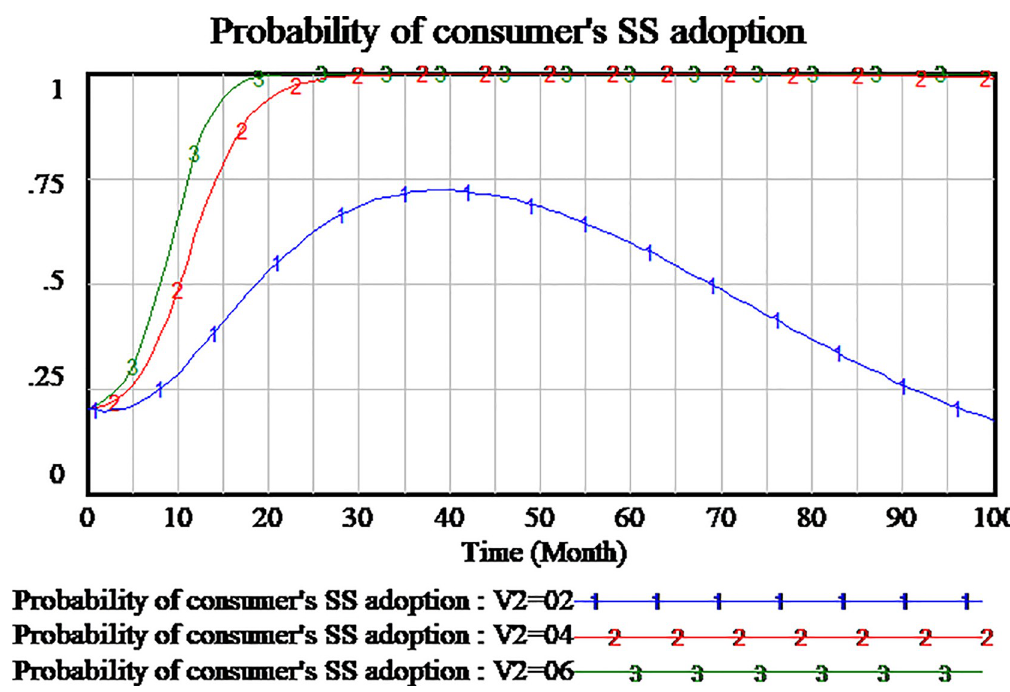
Fig 13. Impact of different compensation on consumer.